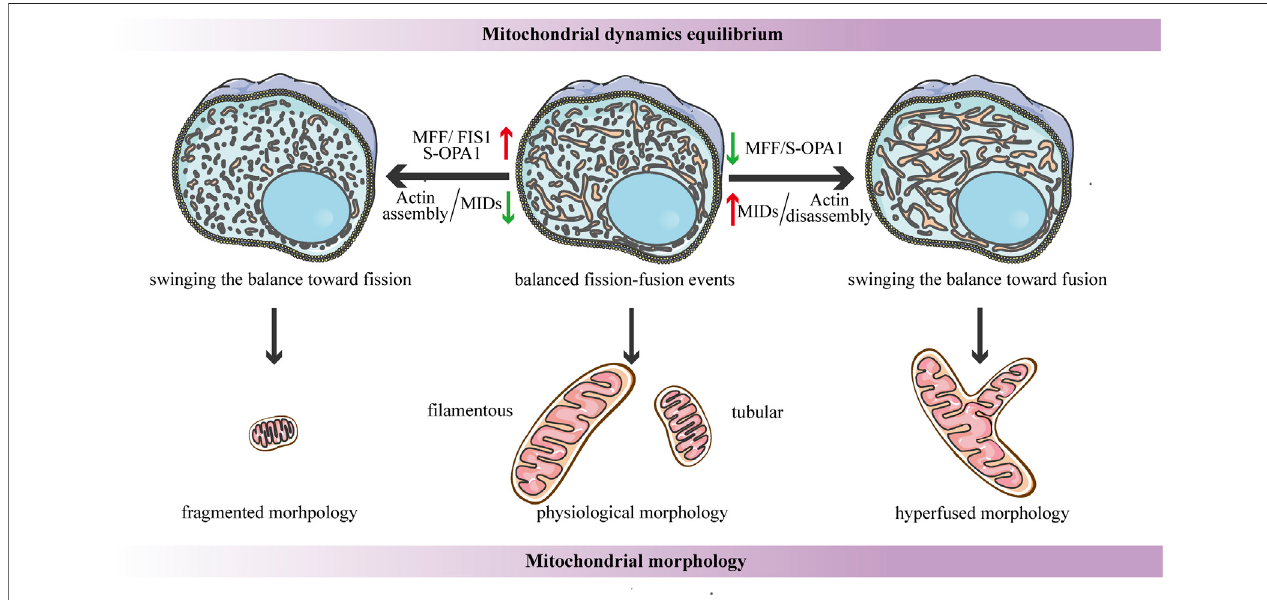
FIGURE 4 | Schematic diagrams of the regulation of mitochondrial dynamics equilibrium and its connection to mitochondrial morphology. Under steady-state conditions, the fi ssion-fusion cycle is constantly maintained in an appropriate equilibrium, bringing about characteristic, fi lamentous or tubular mitochondrial morphologies. This dynamic balance can be affected by many factors. The dynamic actin cycle plays an important role in the regulation of mitochondrial dynamics equilibrium. Actin assembly induces mitochondrial fi ssion, whereas actin disassembly promotes fusion. Moreover, S-OPA1 and the corresponding receptors of DRP1 are involved in the regulation of mitochondrial dynamics balance. The overexpression of MFF/FIS1/S-OPA1 can tip the balance toward fi ssion, similarly, low-to- moderate levels of MIDs prefer to shift the balance toward fi ssion, leading to a fragmented mitochondrial network. In contrast, the overexpression of MIDs or the low-to- moderate level of S-OPA1, as well as the inhibition of MFF, can swing the dynamic equilibrium in the direction of fusion, resulting in a hyperfused mitochondrial morphology.